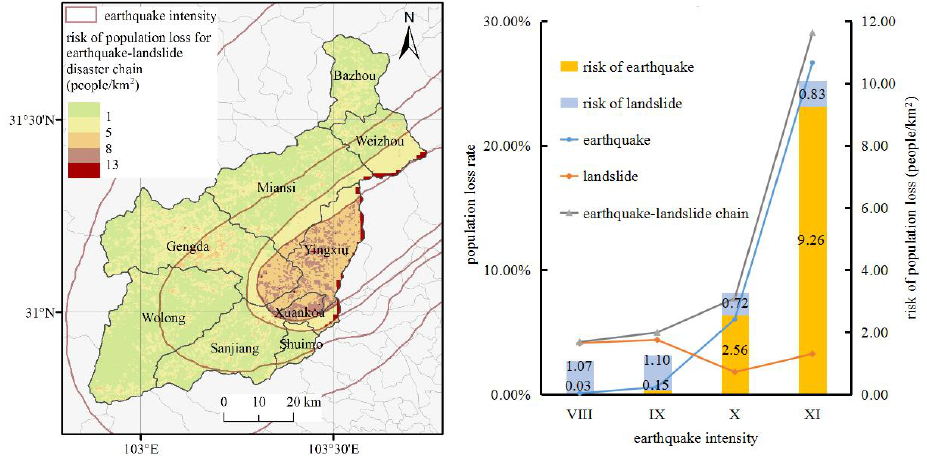
Figure 10. The risk and rate of population loss posed by the earthquake-landslide disaster chain in Wenchuan.